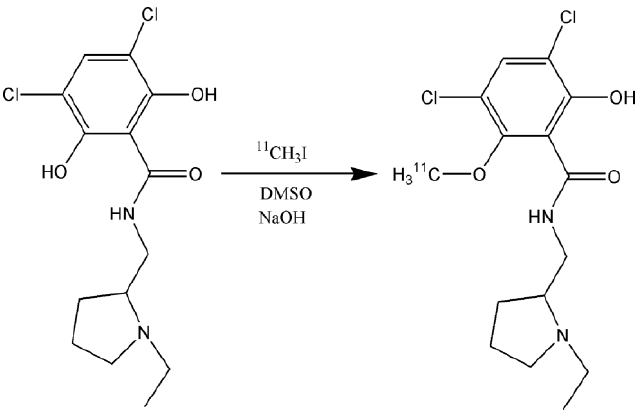
Figure 1. Synthesis of [ 11 C]RAC starting from the free base precursor DM-RAC and 11 CH 3